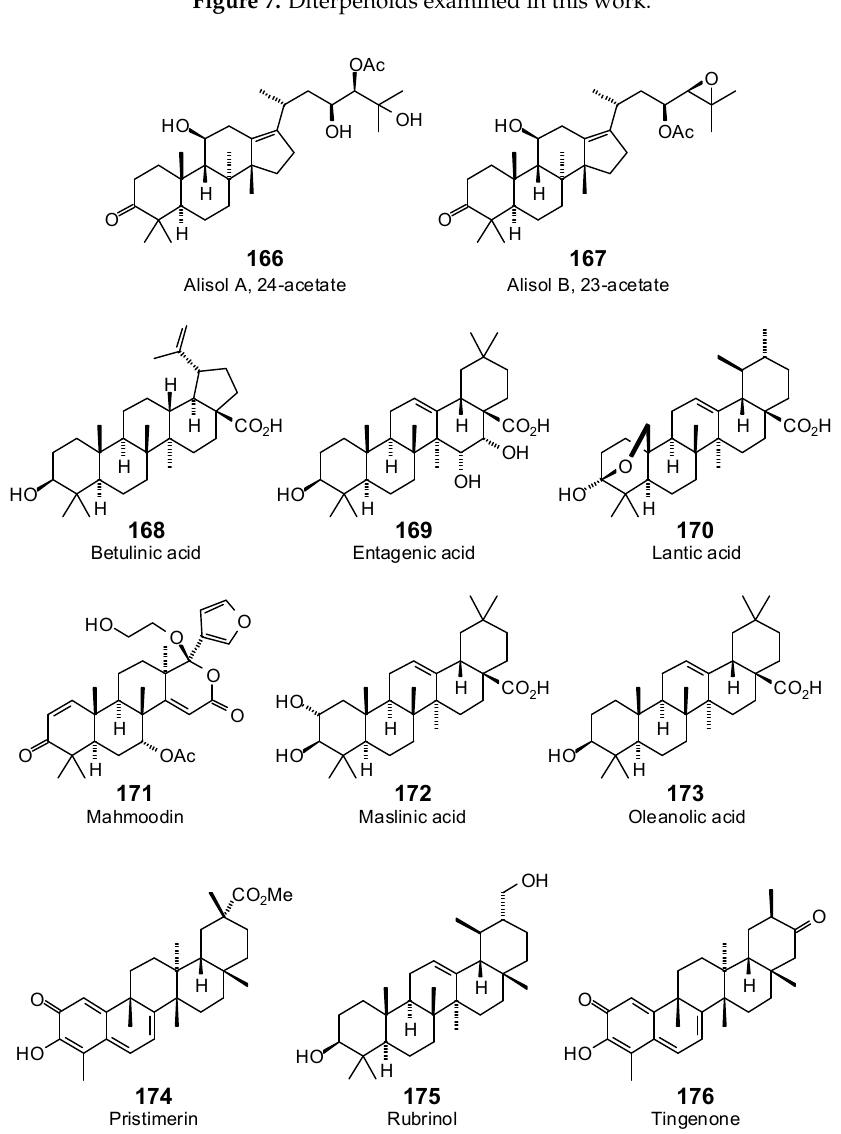
Figure 8. Triterpenoids examined in this work.